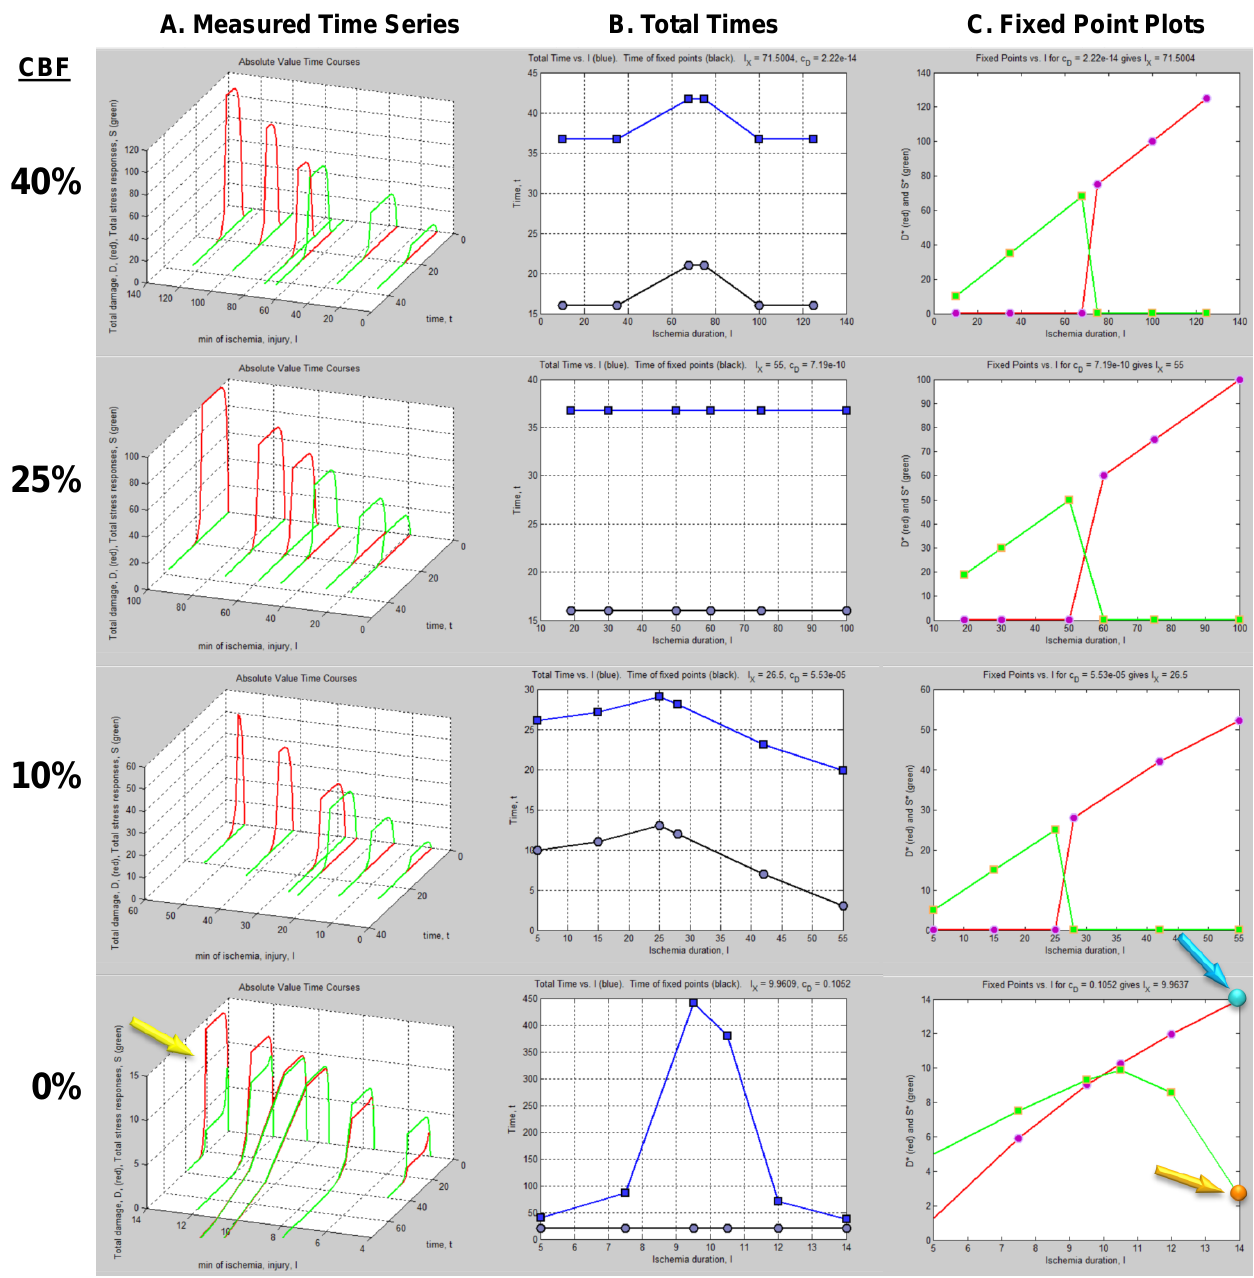
Figure 6. Hypothetical time series “experimental data”. ( A ) Hypothetical measured D (red) and S (green) time courses at %CBF as indicated. The x -axis is the parameter I , here the ischemia duration; y -axis is time, t , and z -axis is D or S . ( B ) Total duration of D and S time courses (blue lines) and durations to the fixed points (black curves). ( C ) Fixed point plots of D* (red) vs. I and S* (green) vs. I . Yellow arrow indicates time courses used for derivative in Figure 7. Blue and orange arrows point to D* and S* calculated by derivative plot in Figure